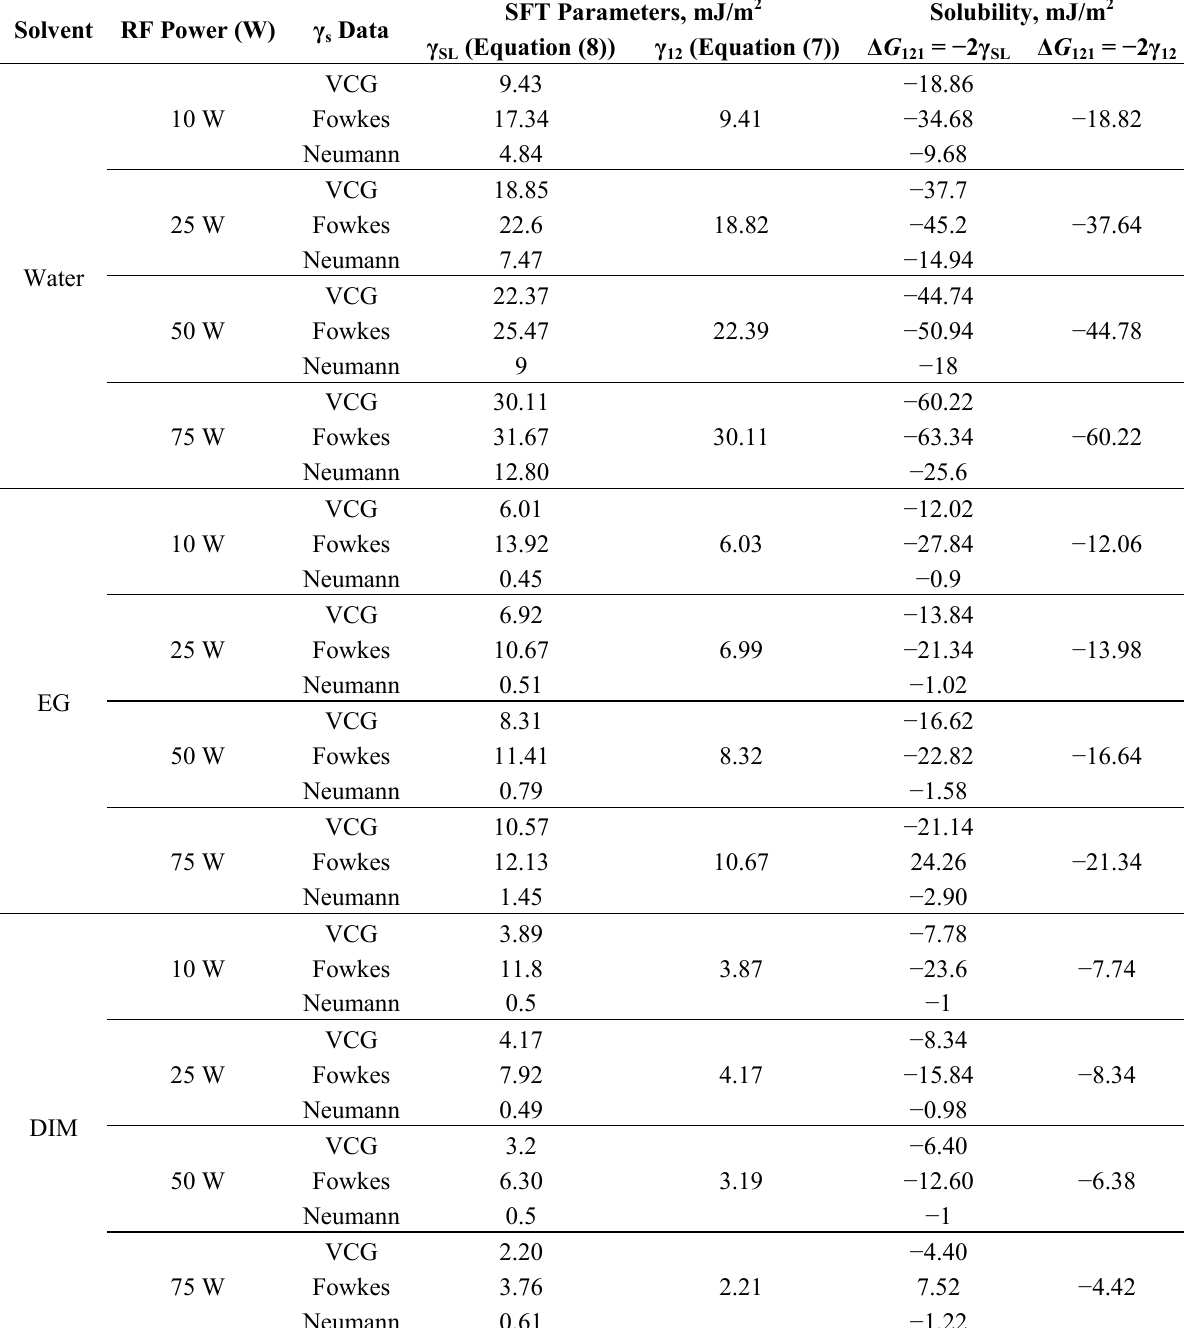
values obtained using Equations (5)–(7) from the derived surface tension ∆𝐺 121